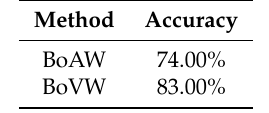
Table 11. Results on the Caltech 101